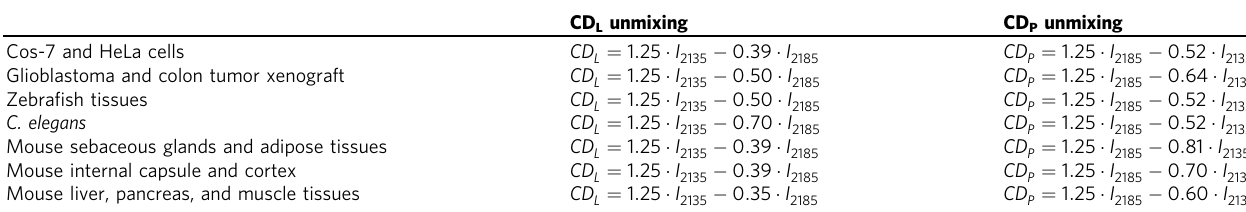
Table 1 Equations used for CD L /CD P signal unmixing Cos-7 and HeLa